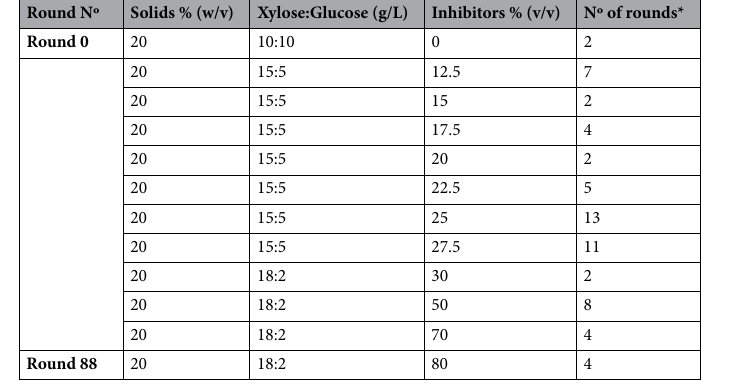
Table 1. Strategy followed during the ALE in terms of insoluble solids, xylose:glucose and inhibitors concentration for each round. *Number of rounds under each condition.